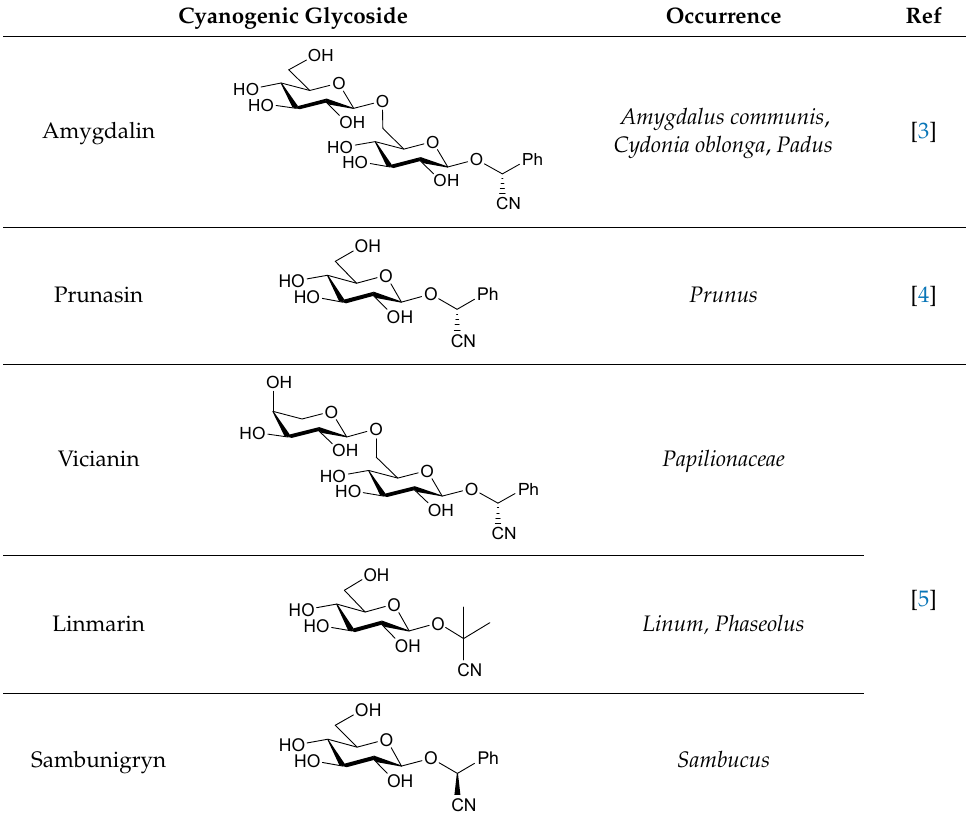
Table 1. Information on selected cyanogenic glycosides.